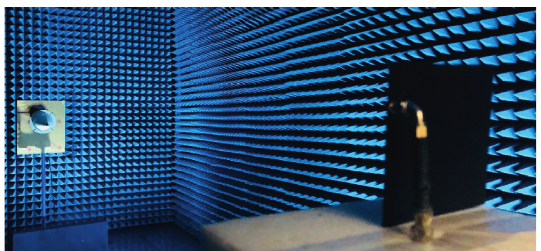
Figure 16: The experimental setup for radiation measurement in anechoic chamber.